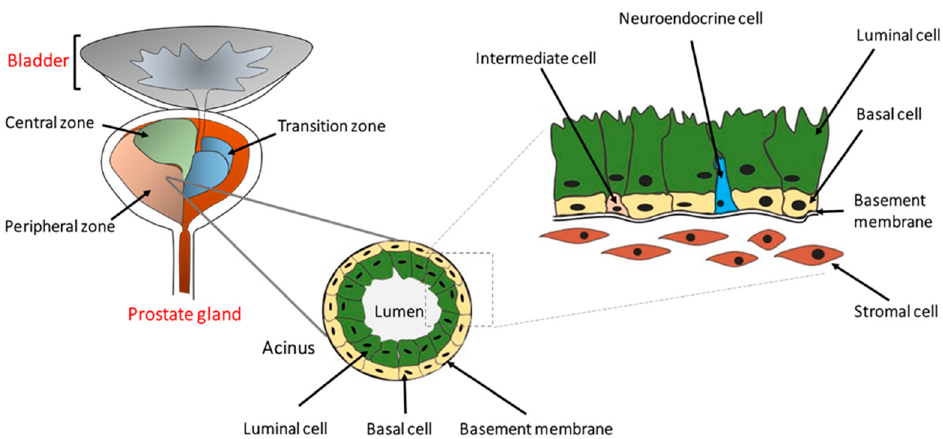
Figure 1. The location and architecture of the human prostate gland. The prostate gland is located below the bladder and consists of a central, a peripheral, and a transition zone. Histologically, it is comprised of secretary luminal, basal, and rare intermediate and neuroendocrine cells. The prostatic epithelium is separated from the stromal cells by the basement membrane as indicated. Preneoplastic or neoplastic cellular transformation can initiate from either basal or luminal cells.